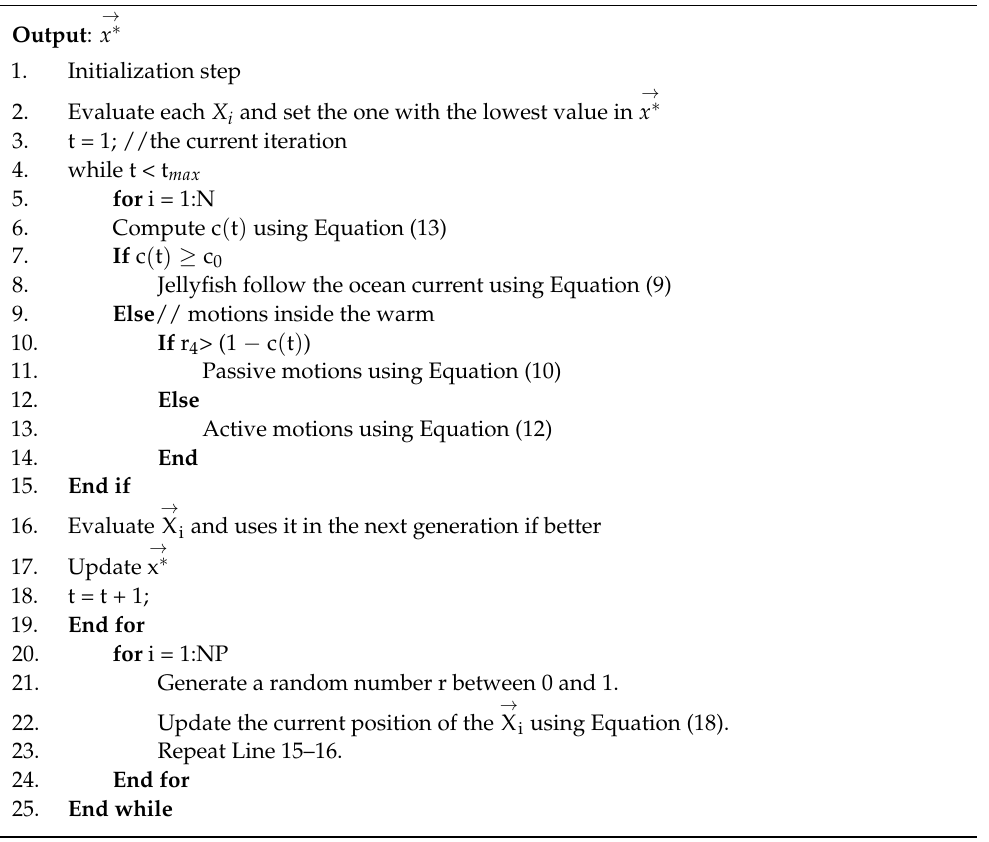
Algorithm 1. The MJSO for the parameter estimation of PV